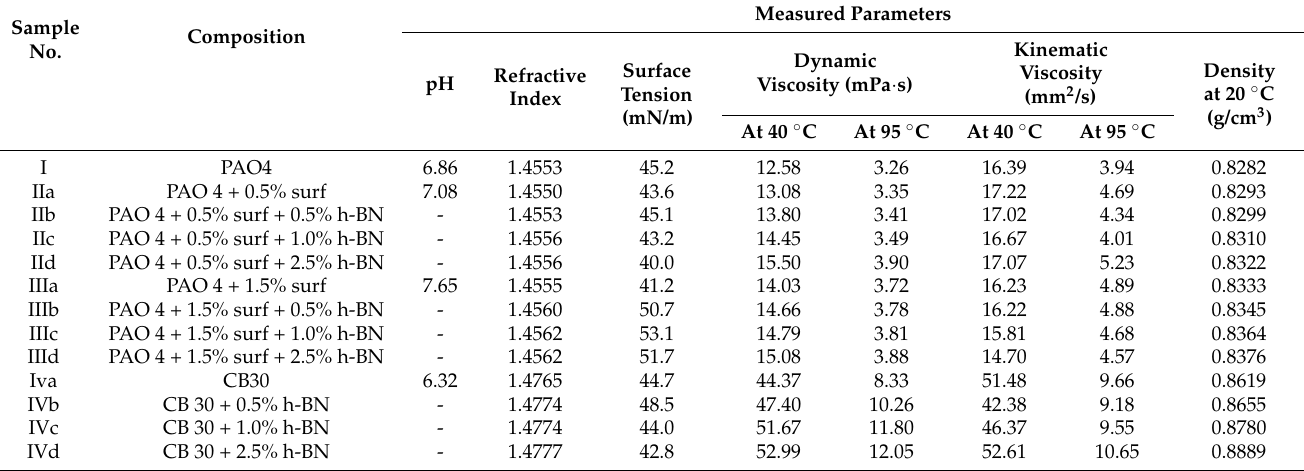
Table 8. Physicochemical results